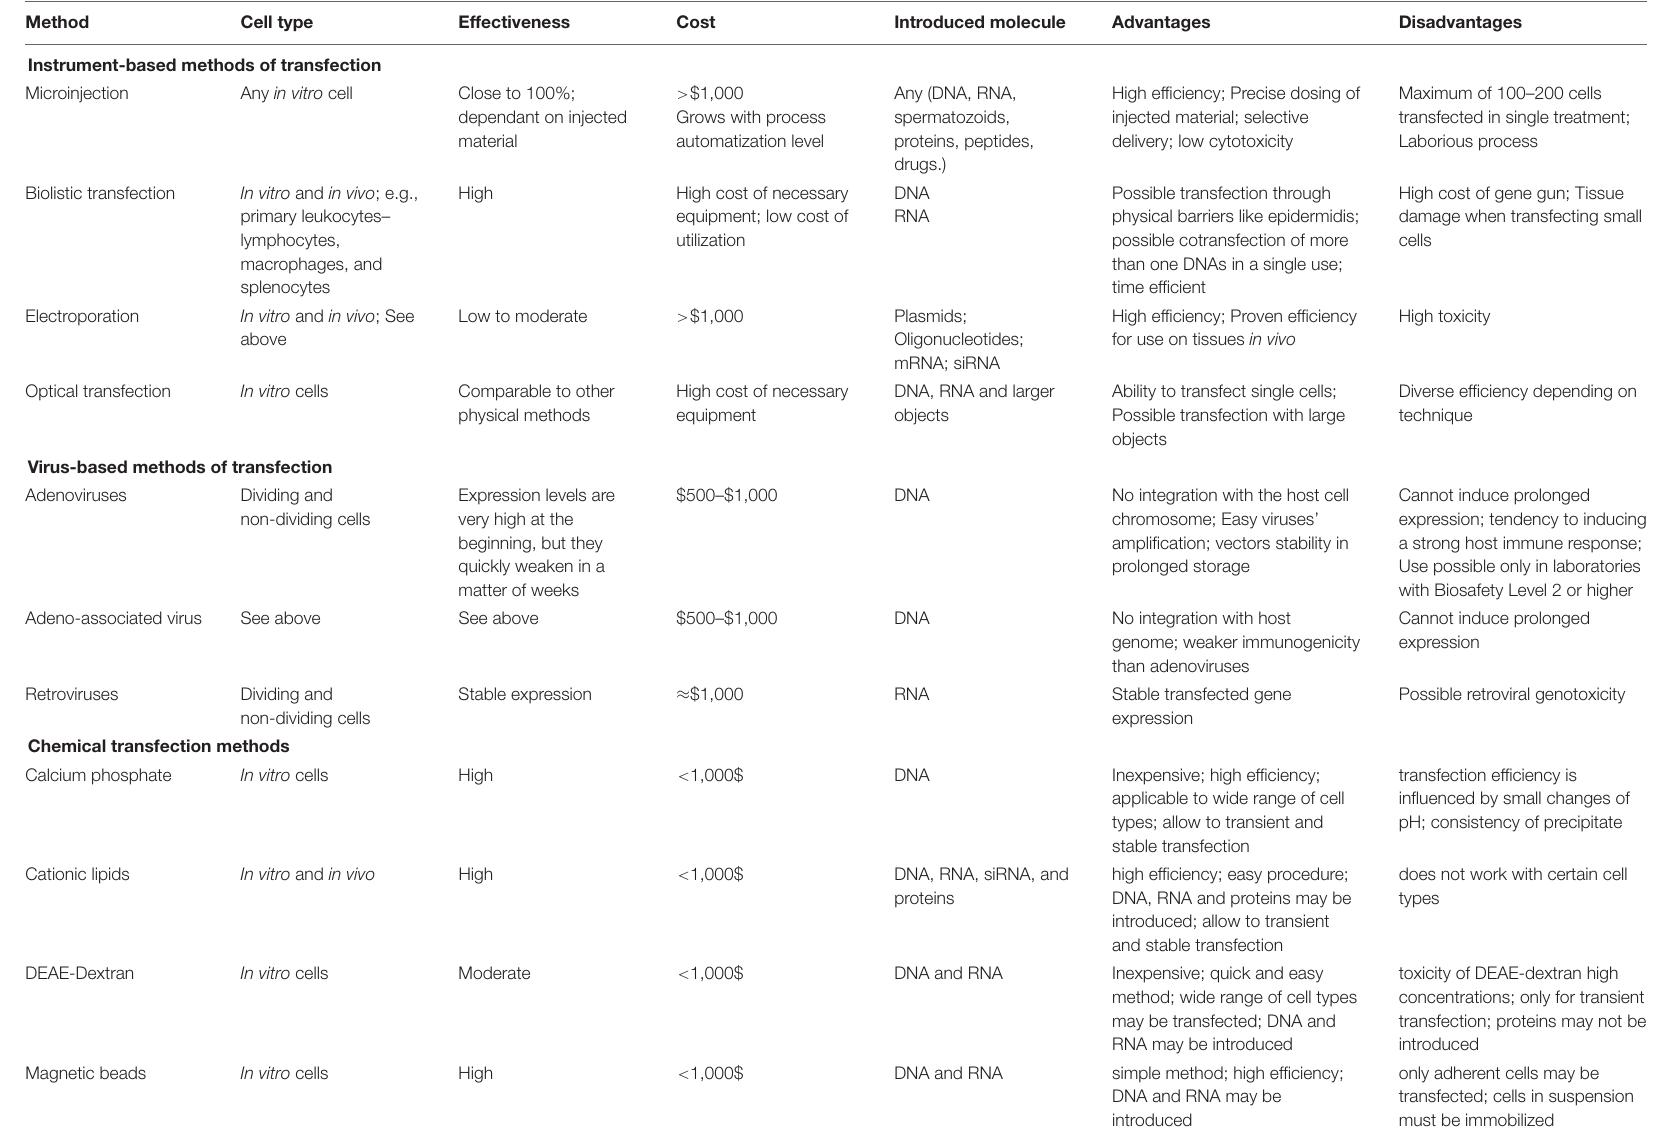
TABLE 1 | Overview of transfection methods.